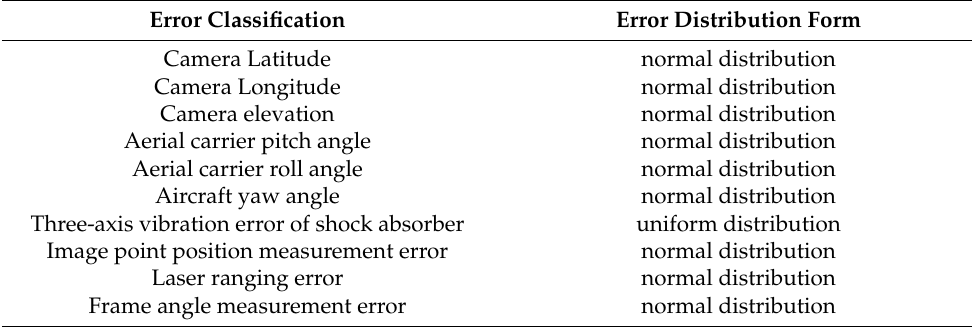
Table 2. Major Error Terms and Their